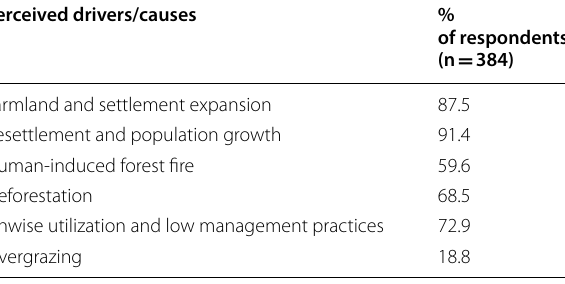
Table 9 Households’ perceived drivers of vegetation cover change in Chewaka district